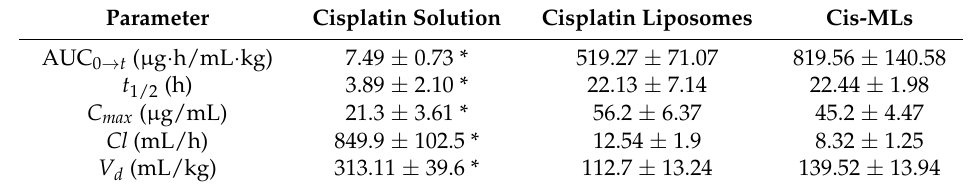
Table 3. Pharmacokinetic parameters of iron after intravenous administration of Cis-MLs ( n = 6).